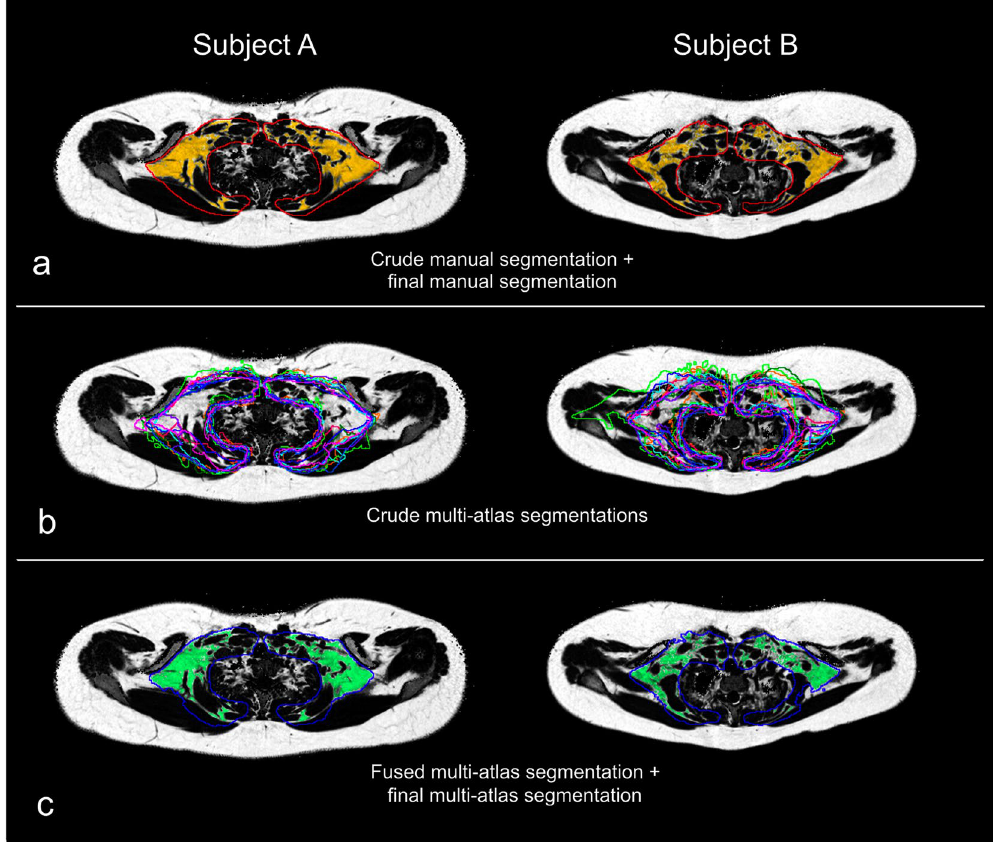
Figure 3. Examples of segmentation results from the semi-automated reference segmentation (REF) method and the automated multi-atlas segmentation (MAS) method. Axial fat fraction (FF) maps of two of the 16 evaluation (E) subjects A and B are overlaid with ( a ) the crude manual delineation (red contour) and the final manual segmentation after fine adjustment (sBAT REF , yellow area), ( b ) the crude multi-atlas segmentations (multi-colour contours) and ( c ) the fused crude multi-atlas segmentation (blue contour) and the final multi- atlas segmentation after fine adjustment and refinement (sBAT MAS , green area). Subject A: female, age = 16 years, BMI = 35.2 kg/m 2 . Subject B: female, age = 11 years, BMI = 28.6 kg/m 2